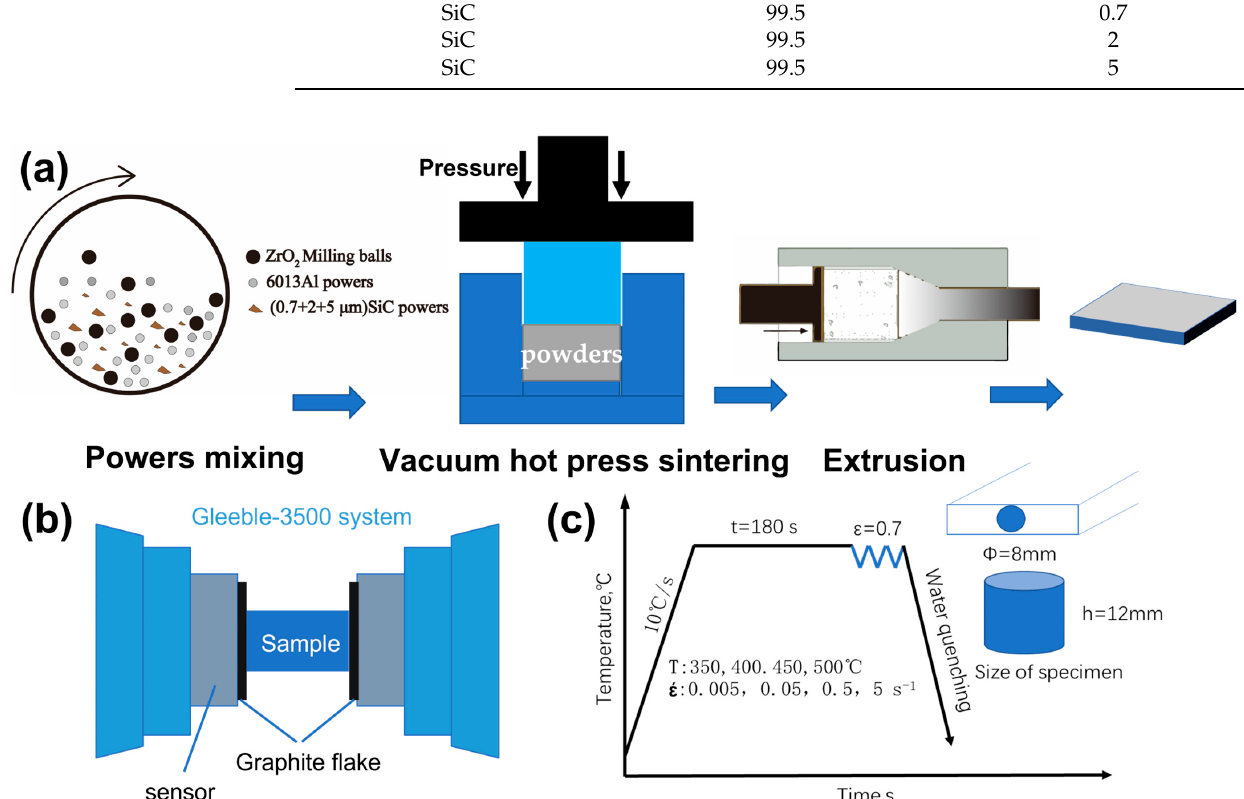
Figure 1. ( a ) Schematic diagram of the composite manufacturing process; ( b ) schematic diagram